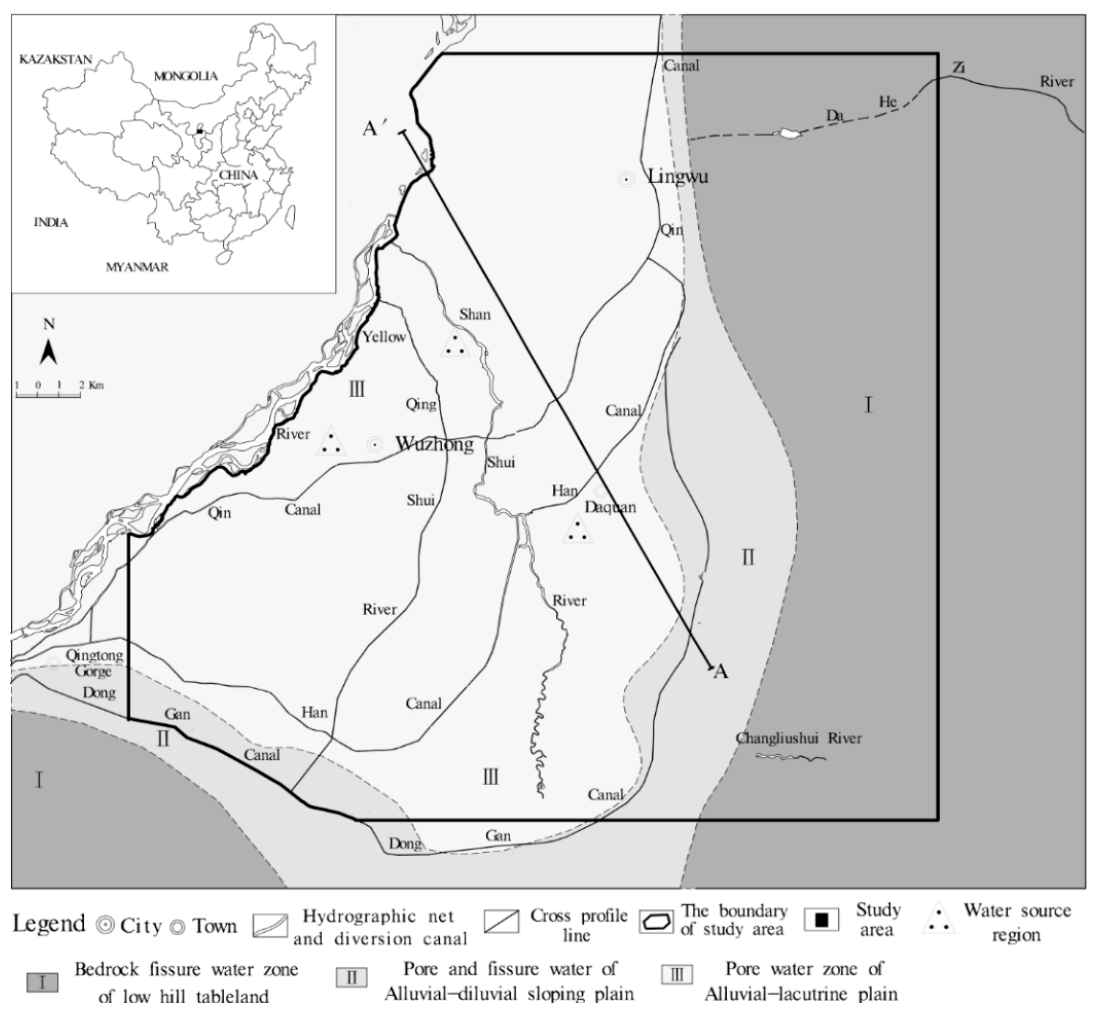
Figure 1. The location of the study area and hydrogeological zones within it.